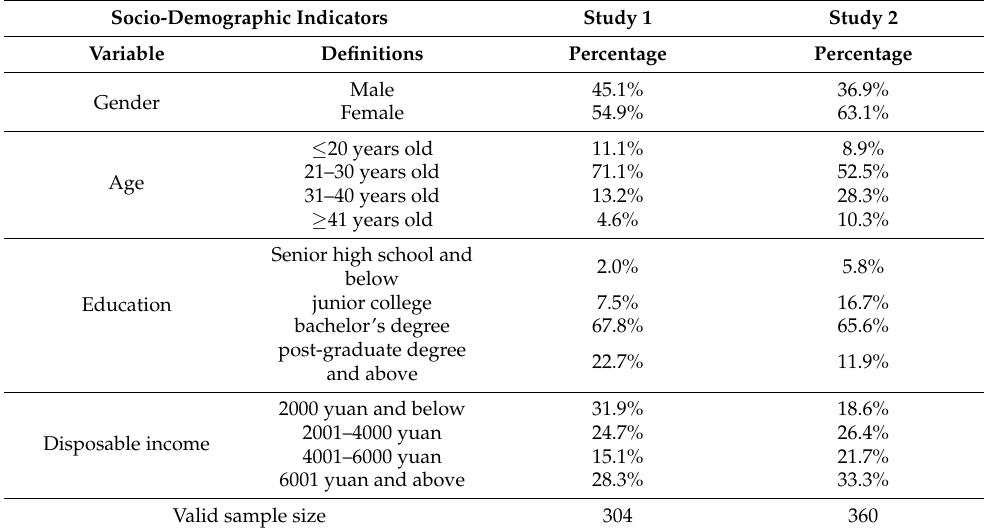
Table 2. Socio-demographics of consumers in Study